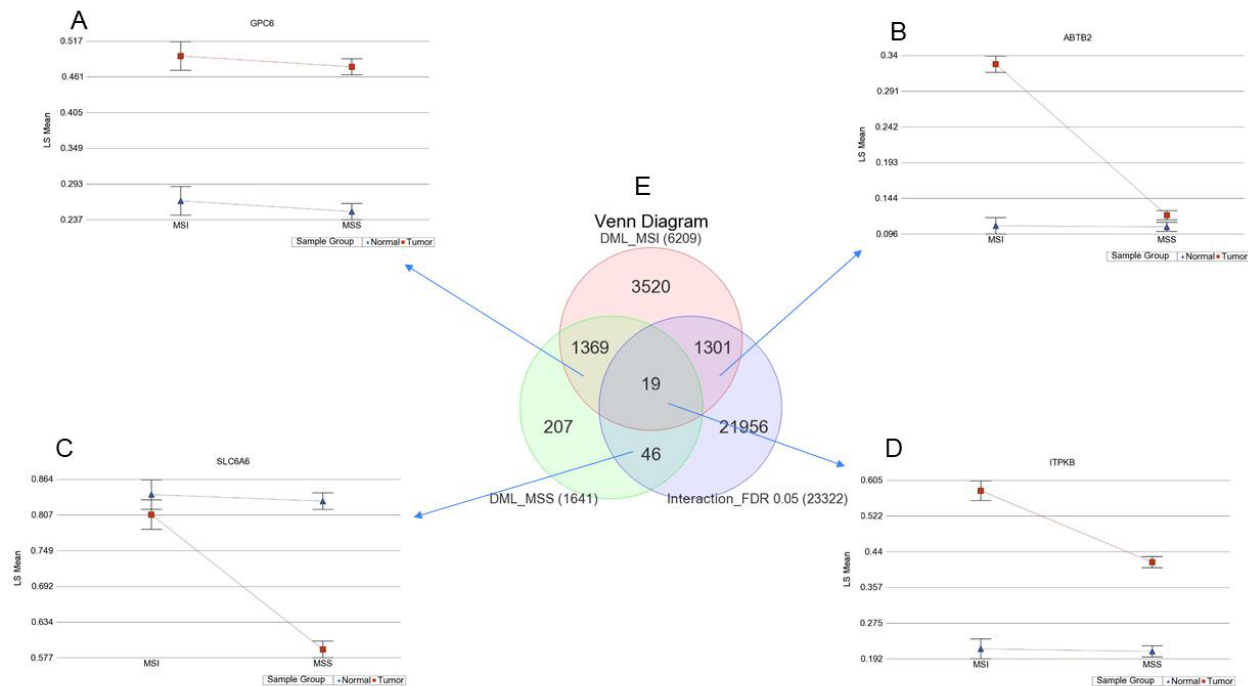
Figure 5. DML among MSI and MSS patients and different forms of interaction: ( A ) shows an example of the glypican 6 ( GPC6 ) gene with no interactions where the tumor tissue shows significantly higher methylation compared to normal in both MSI and MSS tumors, and the magnitude of the difference is almost equal. ( B ) Shows an example of ankyrin repeat and BTB domain containing 2 ( ABTB2 ) gene where the tumor tissue shows marked hypermethylation in MSI tumors, but not that much in MSS. ( C ) Shows an example of the inositol-triphosphate 3-kinase B ( ITPKB ) gene, which is hypermethylated in tumor tissue irrespective of MSI status, but the magnitude of the difference is higher if the tumor is MSI compared to when the tumor is MSS. ( D ) Shows an example of the solute carrier family 6 member 6 ( SLC6A6 ) gene, which is markedly hypomethylated in MSS tumors and the magnitude is significantly more in MSS than MSI. ( E ) Venn diagram showing the overlap between the lists of DML in MSI, MSS, and the list of loci showing significant interaction between tumor and MSI status (interaction p -value FDR 0.05).